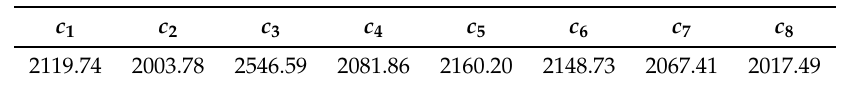
Table 2. Objective coefficient (yuan/t).